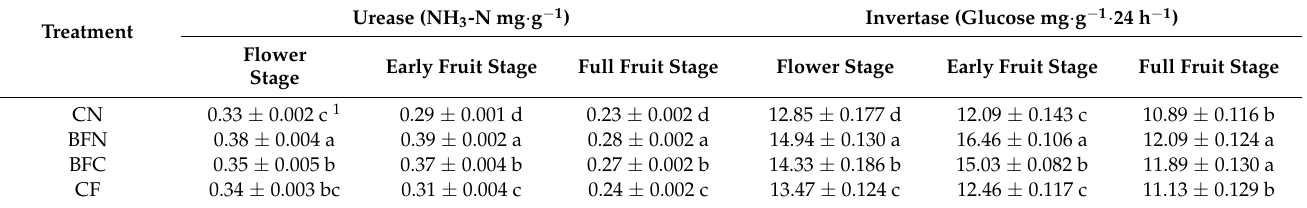
Table 3. Effect of different treatments on soil enzymatic activities at different eggplant growth stages across the